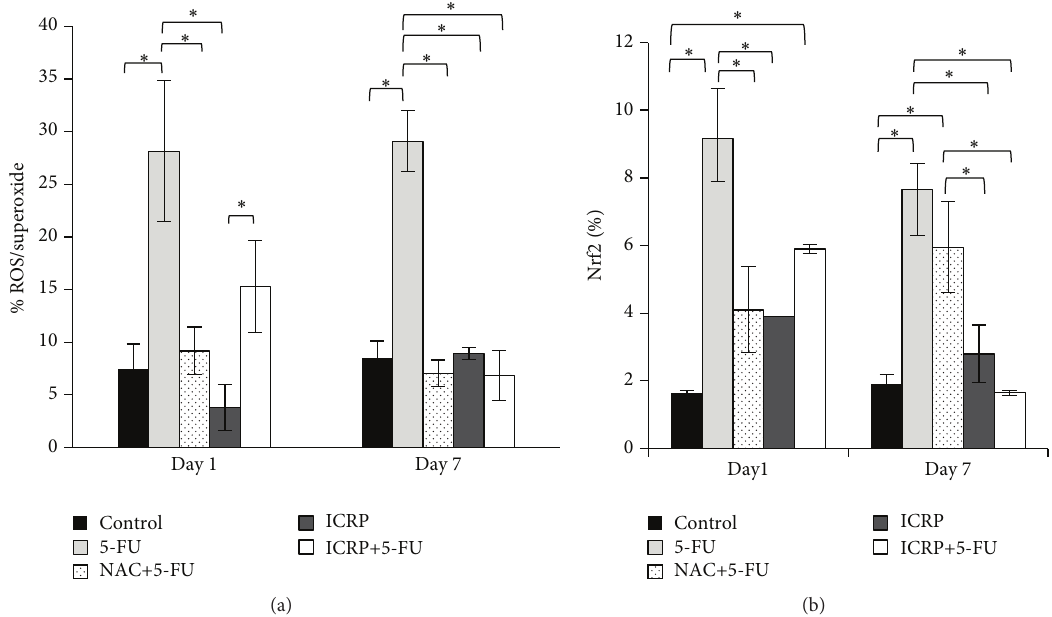
Figure5:(a)ROS/superoxideanalysis:BMcellsfrombothfemoraandtibiawereobtainedonday1andday7fromtreatedmice.Subsequently, BM cells were stained for ROS/superoxide detection by flow cytometry. (b) Nrf2 analysis: BM cells from both femora and tibia were obtained on day 1 and day 7 from treated mice. Subsequently, BM cells were fixed and permeabilized for intracellular staining ∗ (𝑃 < 0.05 ) ( 𝑛 = 3 ).